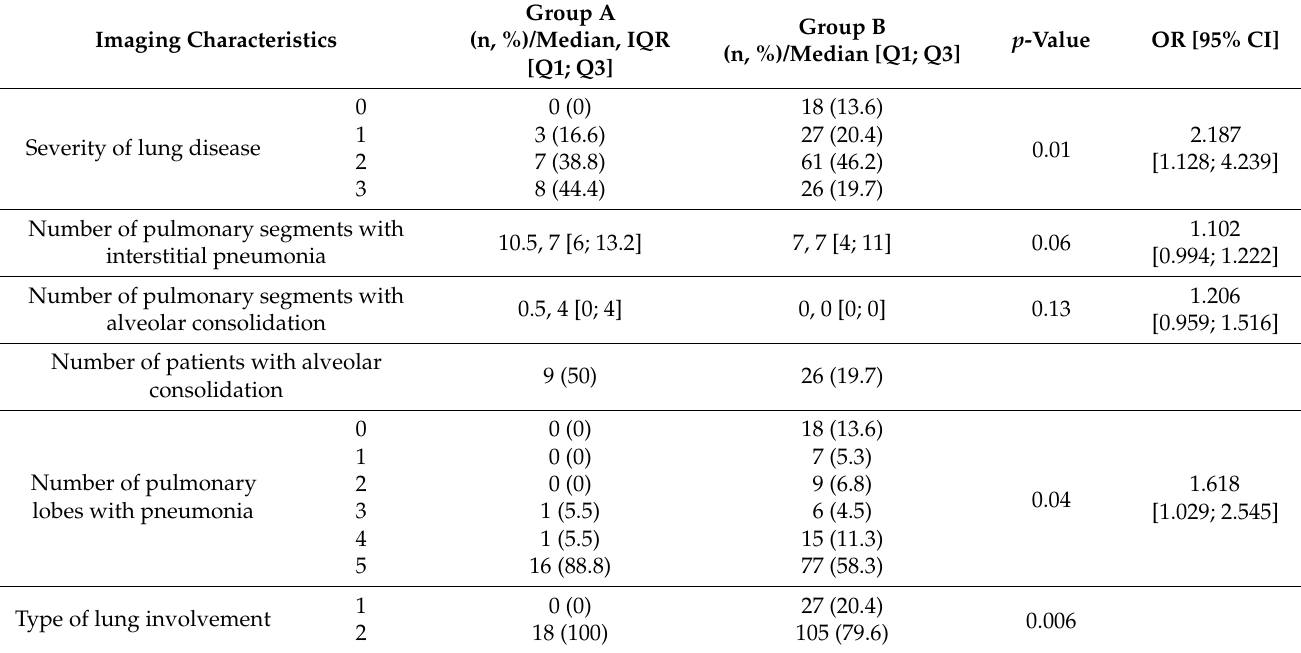
Table 3. Radiological characteristics in COVID-19 patients with and without myocardial